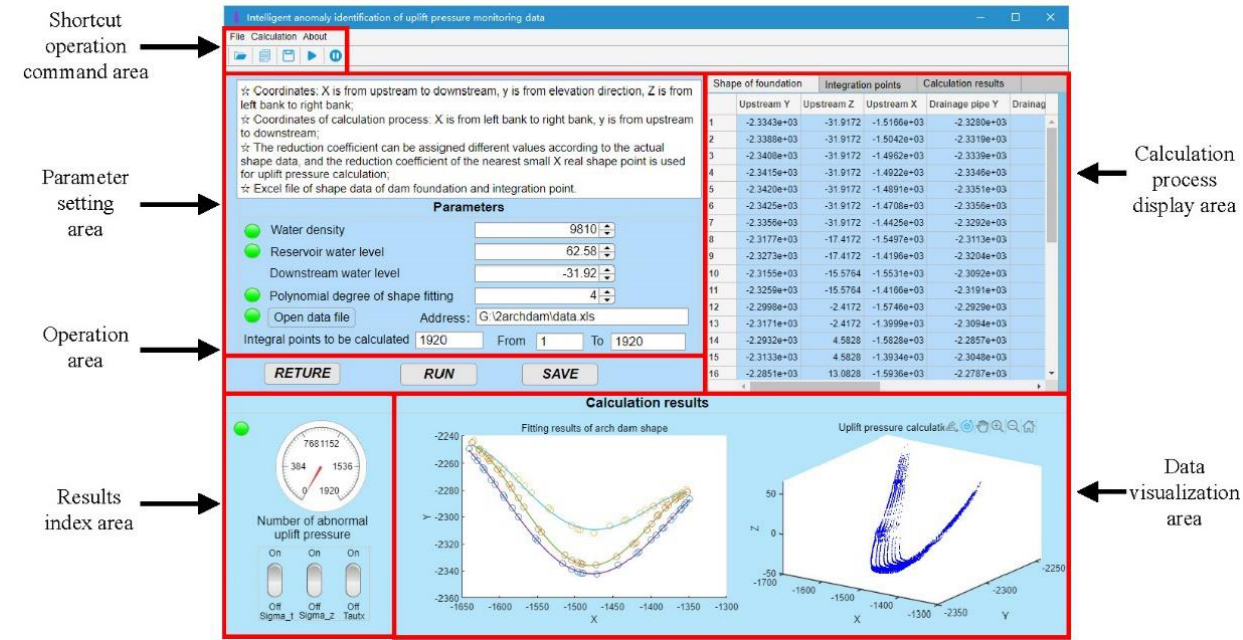
Figure 4. Software interface of the application method of measured uplift pressure.